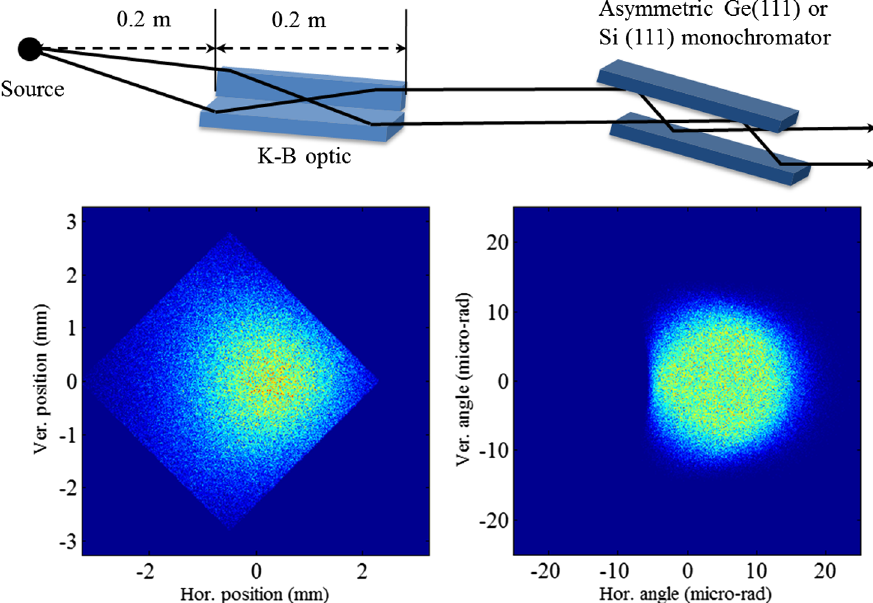
FIG. 8. Geometry and simulation results for collimating optics. A nested KB mirror with graded multilayer coating collects 5% bandwidth radiation at 24 mrad grazing angle. The ICS source size ( 2 μ m) and opening angle (4 mrad) are converted to a synchrotron- like beam with output rms beam size of 0.94 mm and rms divergence of 5 . 6 μ rad. Total efficiency is 40% including 80% collection efficiency and 70% surface reflectivity.